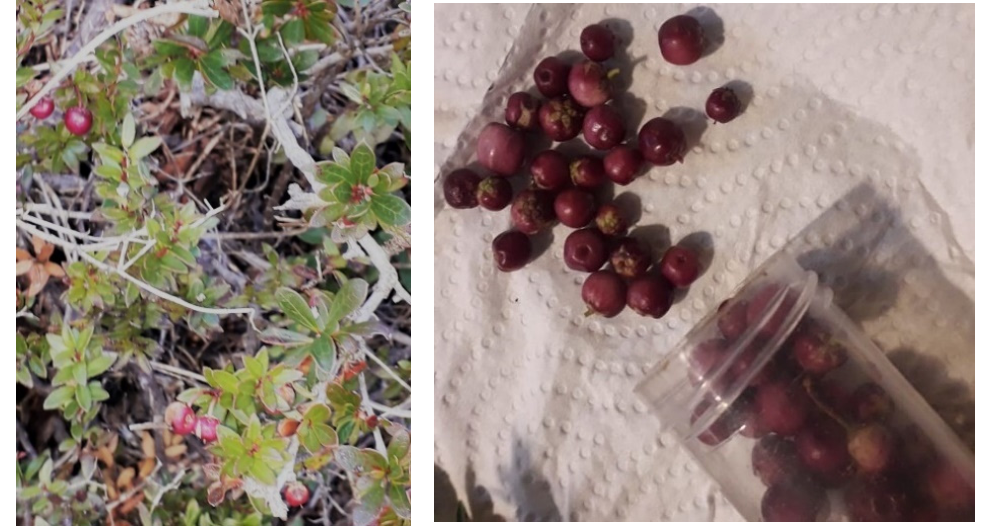
Figure 1. Gaultheria pumila (Ericaceae) shrub in Parque Nacional Conguillío (left) and Gaultheria pumila berries (right).